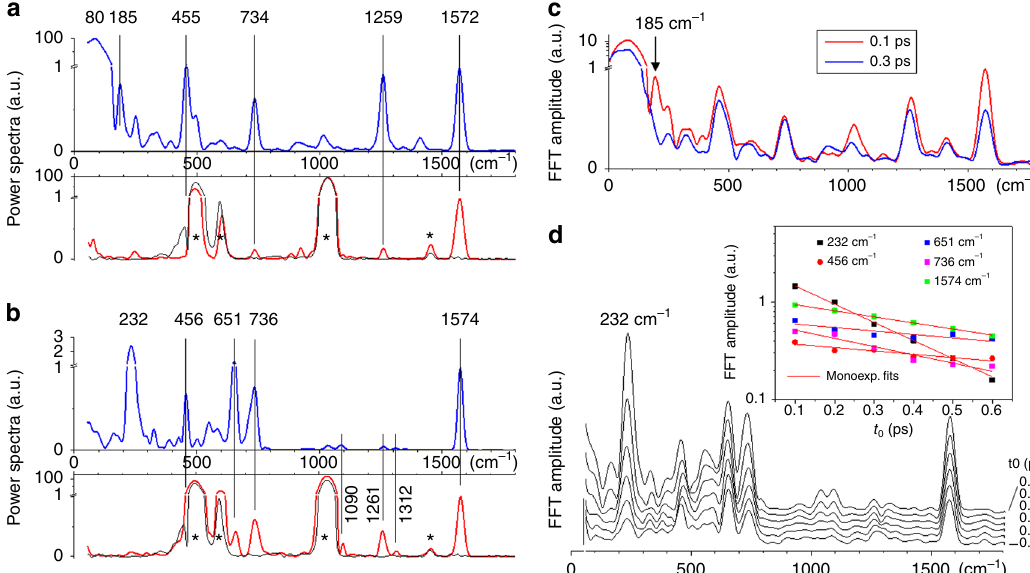
Fig. 3 Vibrational coherence spectroscopy of compounds Z - 1 and E - 2 . The power spectra of the differential absorption Δ A oscillatory residuals revealed in Fig. 2g, h are averaged over the 350 – 470 nm probing window and displayed in a for Z - 1 and b for E - 2 . The spectra are normalized to 1 at the C = C stretch frequency of 1572 or 1574 cm − 1 . The vertical scale is linear from 0 to 1 and logarithmic above 1. They reveal the frequencies of the modes in which vibrational wave packets are observed upon resonant excitation at 400nm (blue spectra). The same analysis is performed on the data acquired upon off- resonance excitation at 800 nm (red spectra). The black spectra correspond to off-resonant excitation of the pure methanol solvent. Stars indicate the vibrational signatures of the solvent or fused silica cuvette. c The same Fourier analysis of the Z - 1 oscillatory residuals is performed now on a sliding, 1-ps long time window starting at t 0 = 0.1 ps (red spectrum) or t 0 = 0.3 ps (blue spectrum) i.e., respectively before and after impulsive decay. The dominant 80 cm − 1 mode persists. The 185 cm − 1 feature instead disappears upon decay to S 0 , but it seems too narrow to represent an oscillatory signal, which would last for only 250 fs, which questions its signi fi cance and interpretation, especially in the proximity of the very intense 80 cm − 1 mode. d Same as c , for E - 2 , with t fi ve dominating modes at 232, 456, 651, 736, 1564 0 starting times ranging from 0.1 to 0.6. The inset displays the semilog plot of the FFT amplitude of the cm − 1 , as a function of t 0 , and the corresponding monoexponential decay fi ts. While the amplitude of all higher-frequency modes decay on the 600 to 1200 fs time scale, the damping of the 232 cm − 1 mode is observed to occur on a signi fi cantly faster 230 fs time scale, in line with the 300 fs excited state